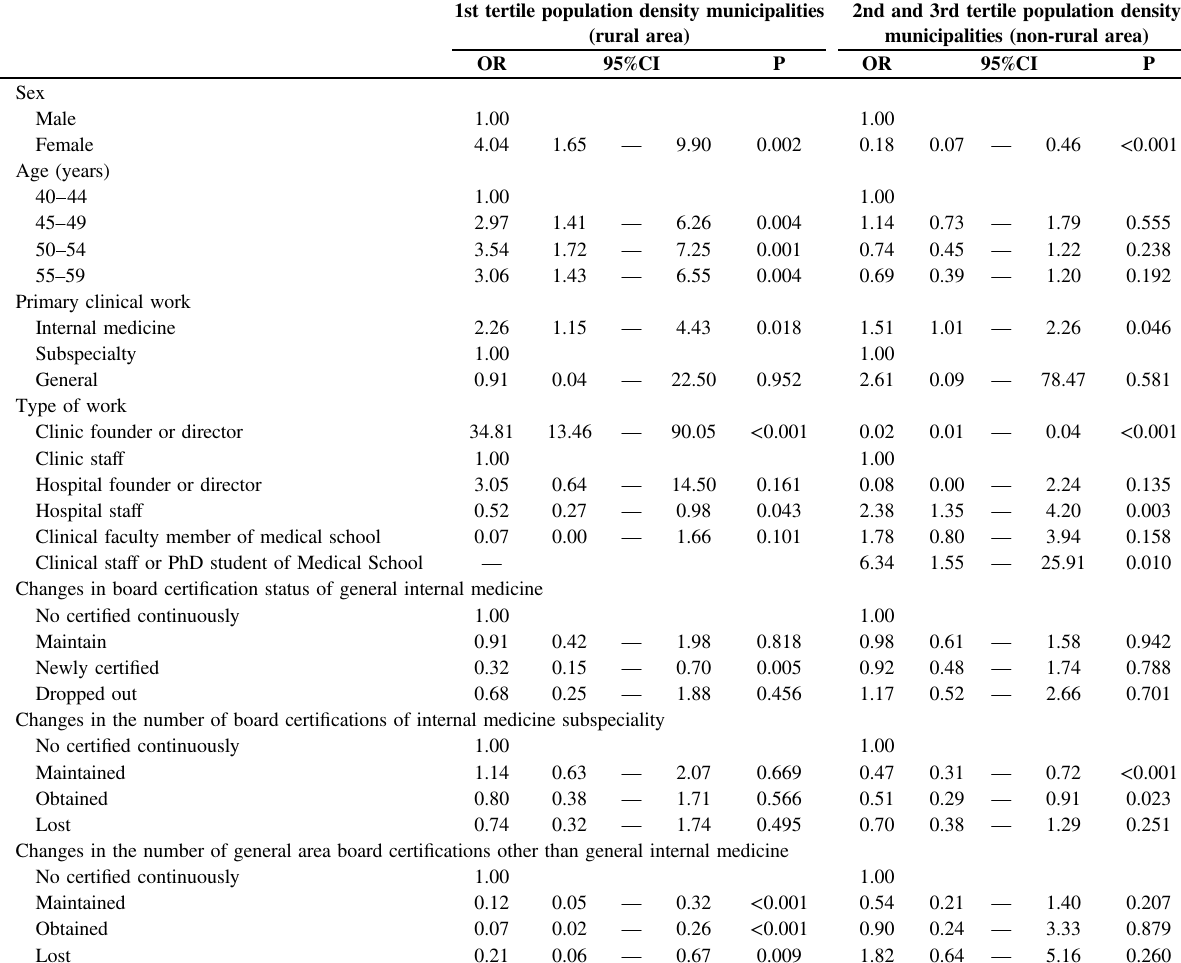
Table 4-2 ORs for working at rural area among IM doctors aged from 40 to 59 years